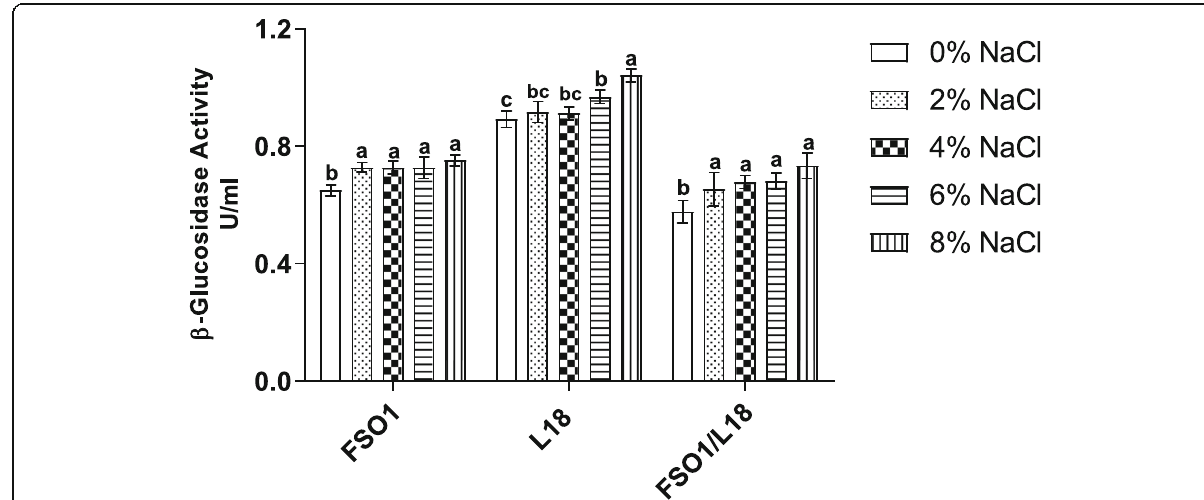
Fig. 11 Residual activity of β -glucosidase after 7 days of cultures at 30 °C for pure (FSO1, L18) and combined (FSO1/L18) cultures in